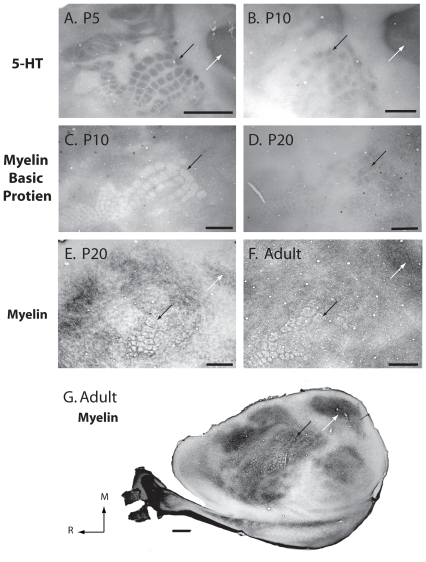
Differential effectiveness of cortical staining techniques.Photomicrographs of primary somatosensory cortex in 5-HT- (A and B), MBP- (C and D), and myelin-stained sections (E, F, and G) in P5 (A), P10 (B and C), P20 (D and E), and adult (F and G) subjects. Visible barrels are indicated with black arrows, and V1 is indicated with white arrows. Different stains work best at different ages. Images were imported into Adobe Photoshop and levels were adjusted to increase contrast. In all photomicrographs, medial is to the top and rostral is to the left. See Table 1 for abbreviations. Scale bar = 1 mm.